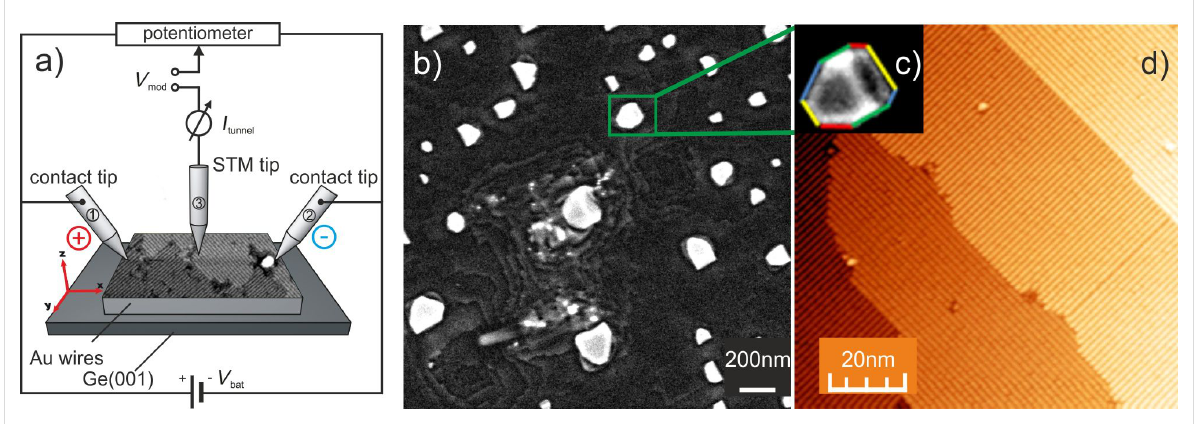
Figure 1: a) Scheme of the potentiometry setup using a multiprobe STM. Two STM tips (1 and 2) in contact with the sample surface are used to drive a lateral current. The third STM tip (3) simultaneously images the topography and the electrochemical potential of the surface. b) HRSEM image of the 6 ML Au/Ge(001) sample surface exhibiting the Au clusters and some terrace edges. Most clusters are of asymmetric octagonal shape as depicted by the colour contour in c). d) HRSTM image of an area between the Au clusters showing two differently oriented domains of the Au induced wires ( I T = 200 pA, V sample = − 2